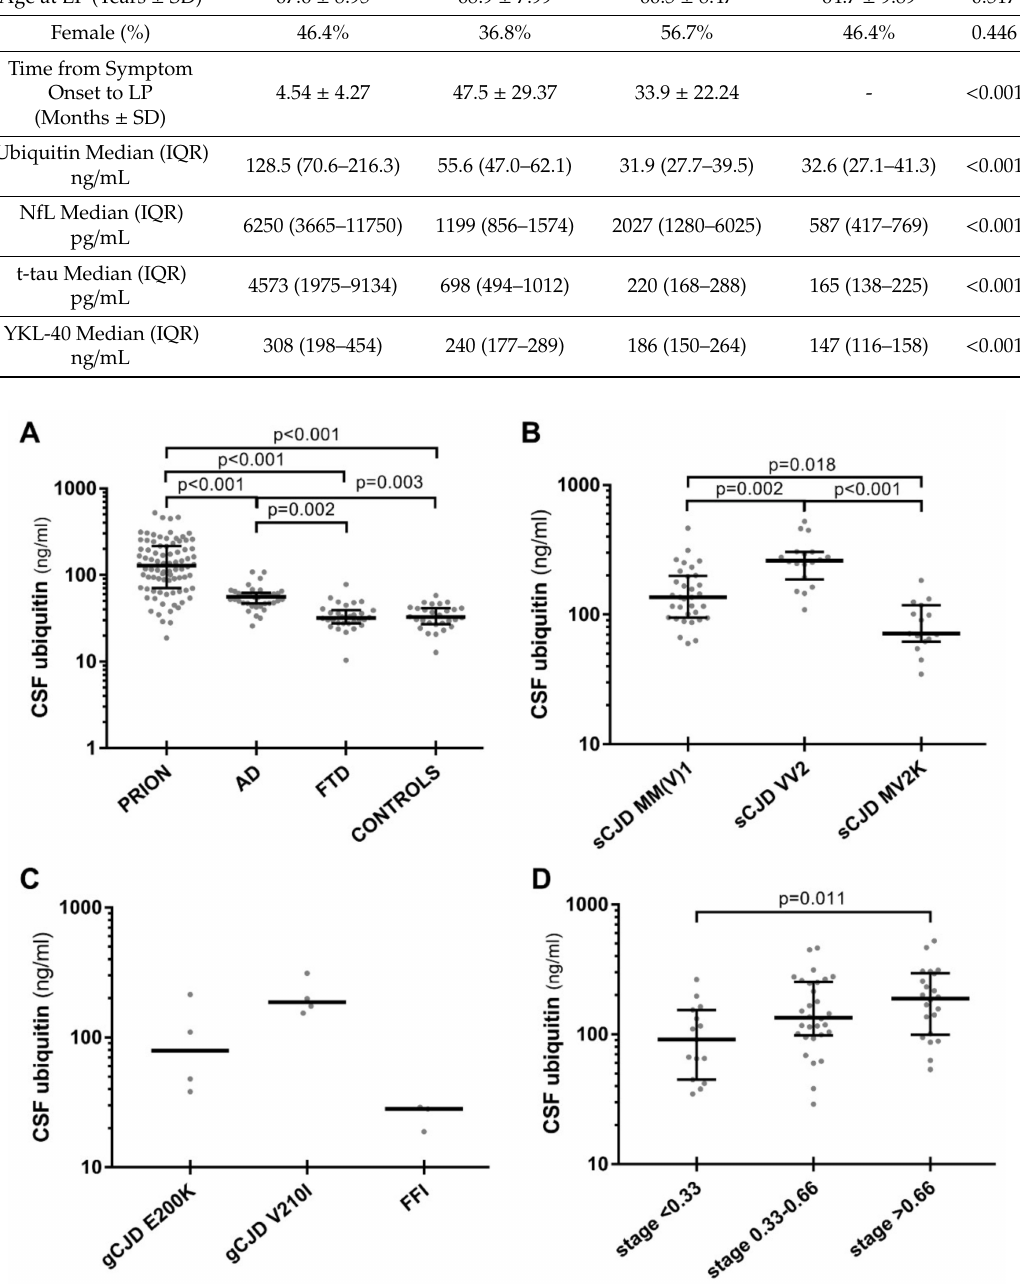
Figure 1. CSF ubiquitin levels in neurodegenerative dementias and in prion disease spectrum. ( A ) CSF ubiquitin levels in prion disease (PRION), Alzheimer’s disease (AD), frontotemporal dementia (FTD) and controls. ( B ) Sporadic Creutzfeldt–Jakob disease (sCJD) VV2 showed significantly higher levels of CSF ubiquitin compared to MM(V)1 and MV2K types. ( C ) CSF ubiquitin in genetic prion disease cases (genetic (g)CJD E200K, gCJD V210I and fatal familial insomnia (FFI)). ( D ) CSF ubiquitin levels increased through disease stages in prion disease. Horizontal lines represent medians. CSF ubiquitin levels are expressed in logarithmic scale. Only statistically significant di ff erences are displayed (Kruskal–Wallis test followed by Dunn–Bonferroni post hoc